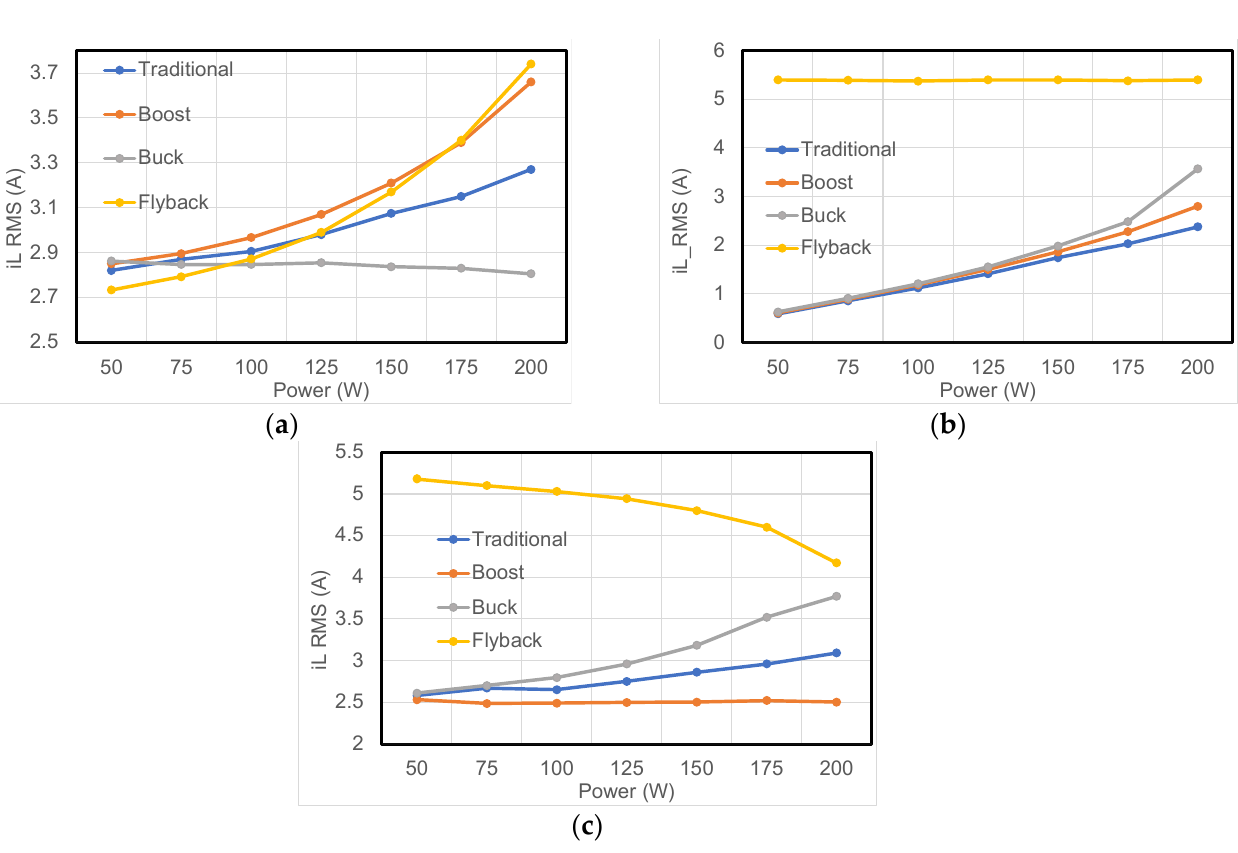
( b ) ( c ) Figure 9. Efficiency results for: ( a ) M = 0.5, ( b ) M = 1, ( c ) M = 2.